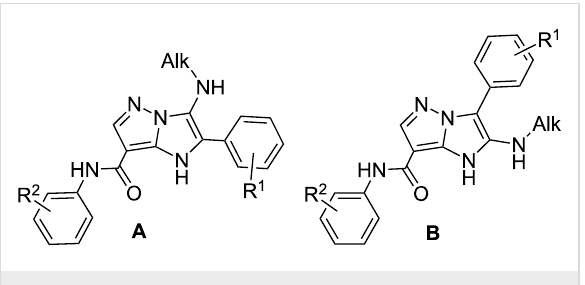
Figure 1: Alternative structures A and B for compounds 4 and 6 . Experiment with D 2 O allowed to identify the signals of NH protons while the HSQC spectrum showed the correlations between the signals of protons and corresponding carbon atoms (in the position 6 and in tert -butyl group). The correlations be- tween the signals of NH protons and corresponding carbon atoms (through two and three bonds, Figure 2) allowed final distinguishing the shifts of three NH groups signals in 1 H NMR spectra.